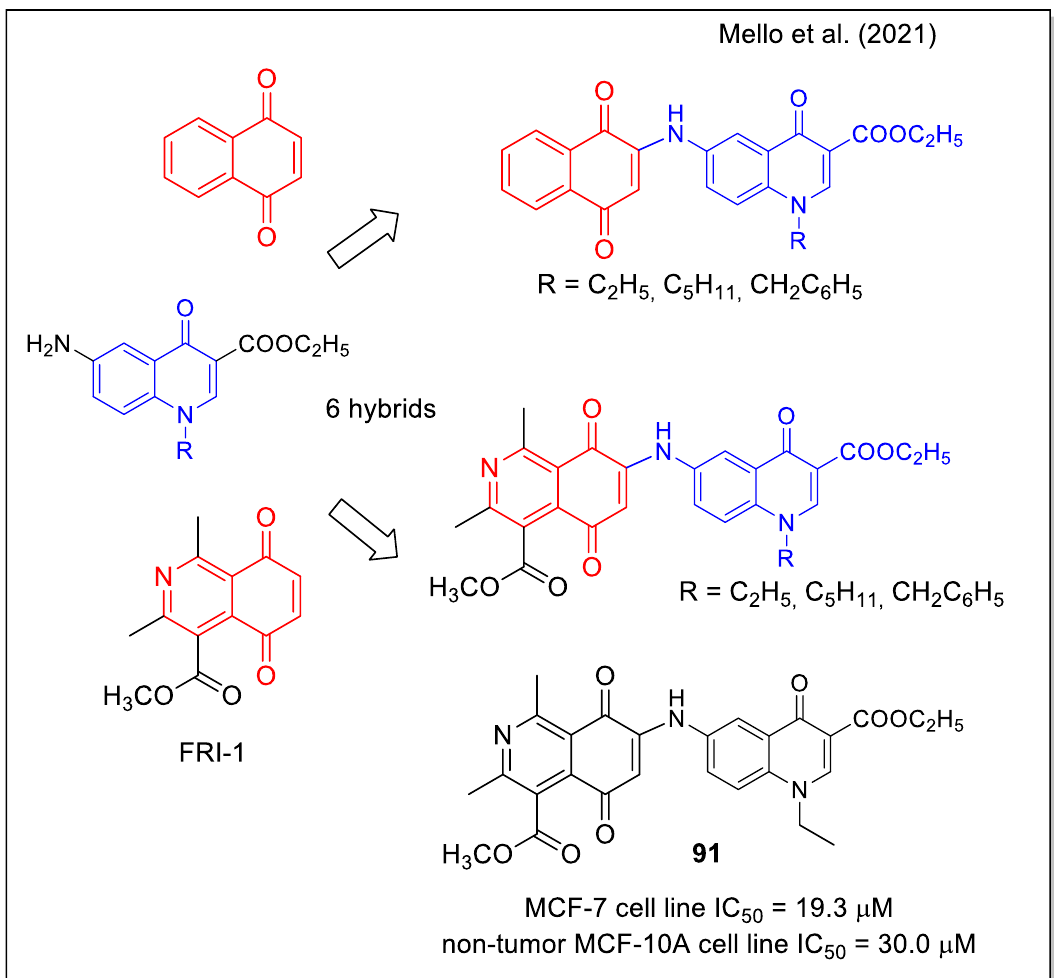
Figure 35. 1,4-Naphthoquinone and isoquinolinedione-4-oxoquinoline hybrids as reported by Mello et al. [78].